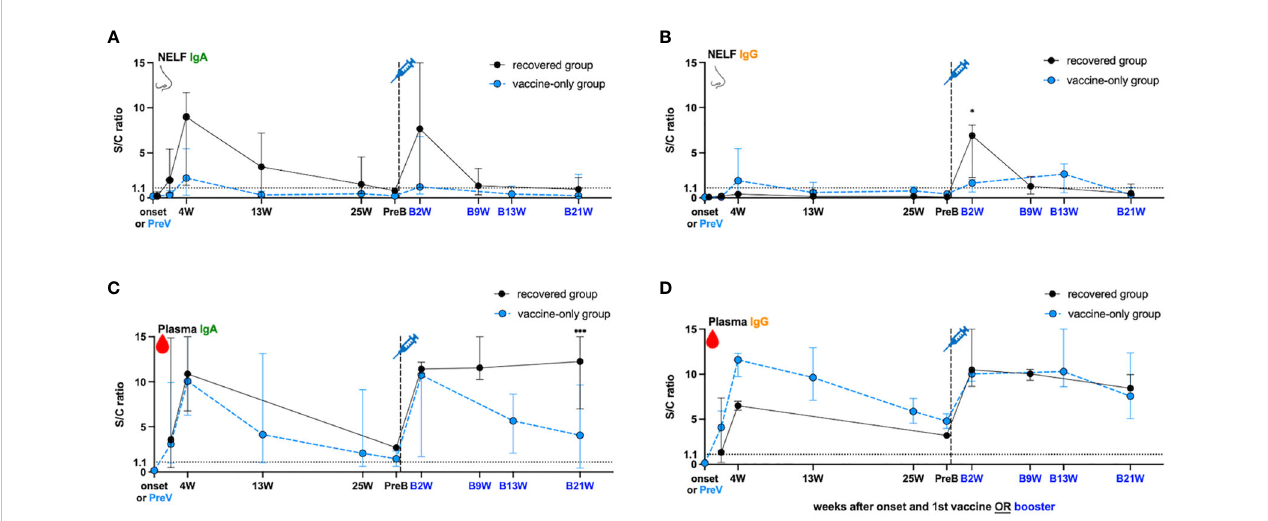
FIGURE 2 SARS-Cov-2 S1- speci fi c antibody dynamic changes in the (A, B) nasal epithelial lining fl uid (NELF) and (C, D) plasma in recovered group (black dots) and vaccine-only group (blue dots). The dynamic changes of S1-speci fi c IgA in NELF (A) and plasma (C) , S1- speci fi c IgG in NELF (B) and plasma (D) are measured, respectively. Antibody-level data points above the dotted line (sample/calibrator (S/C) ration ≥ 1.1) are considered positive, while the S/C ratio = 15 indicates the upper detection limit of the assay. In the recovered group, S1-speci fi c Igs are measured at the onset of the disease (onset), 4 weeks (4W), 13 weeks (13W) 25 weeks (25W) weeks after onset, 0 to 2 days before booster (PreB), 2 weeks (B2W), 9 weeks (B9W) and 21 weeks (B21W) after booster dose. In the vaccine-only group, measurement were done on 0 to 2 days before the fi rst dose of vaccine (PreV), 4 weeks (4W), 13 weeks (13W) and 25 weeks (25W) after the fi rst dose, 0 to 2 days before the third dose (PreB), and 2 weeks (B2W), 13 weeks (B13W), 21 weeks (B21W) after the third dose. The median and 95% CI are plotted. The levels of S1-speci fi c Ig were compared between the recovered group and vaccine-only group by the mann-Whitney rank